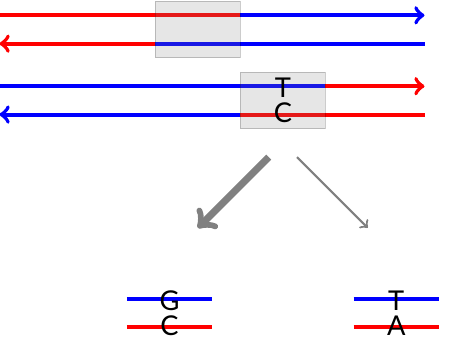
Figure 3 – Figure adapted from Glémin et al. (2014). GC-biased gene conversion (gBGC) occurs after the formation of hetero-duplexes during a meiotic recombination event. Het- eroduplexes can result from crossing-over (shown here) as well as from non-crossover events. In the presence of gBGC, mismatches are repaired more than half of the time in favor of guanine and cytosine rather than adenine and thymine. This bias towards en- richment of guanine and cytosine is of few percent in yeast or humans, leading to the accumulation of GC content within genomes over